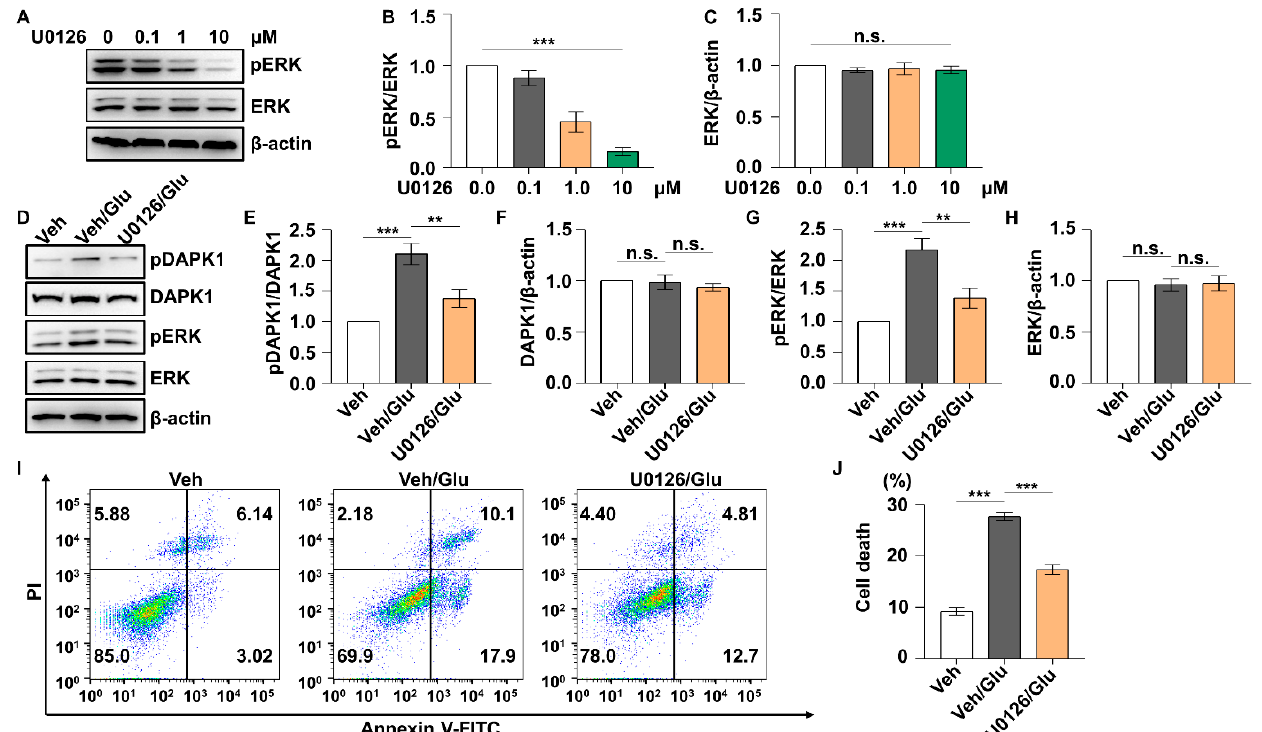
Figure 6. ERK inhibitor reduces DAPK1 activity and apoptosis induced by glutamate. HT22 cells were incubated with 0, 0.1, 1.0, and 10 μ M U0126 for 60 min. ( A – C ) HT22 cell lysates were resolved on SDS-PAGE gels and then subjected to immunoblotting assays with anti-pThr202/Tyr204 ERK, anti-ERK, or anti- β -actin antibodies (*** p < 0.001; one-way ANOVA with Tukey’s multiple comparisons test). HT22 cells were pretreated with 10 μ M U0126 for 60 min followed by washing with PBS. Cells were harvested 1 h after 10 mM glutamate incubation and used in immunoblotting assays using anti-pSer735-DAPK1, anti-DAPK1, anti-pThr202/Tyr204 ERK, anti-ERK, or anti- β -actin anti- bodies ( D – H ), and apoptosis was detected 24 h after glutamate treatment by flow cytometry ( I , J ) (** p < 0.01, *** p < 0.001; one-way ANOVA followed by Tukey’s multiple comparisons test). n.s., not significant ( p > 0.05). All data represent the mean ± SD of three independent experiments.